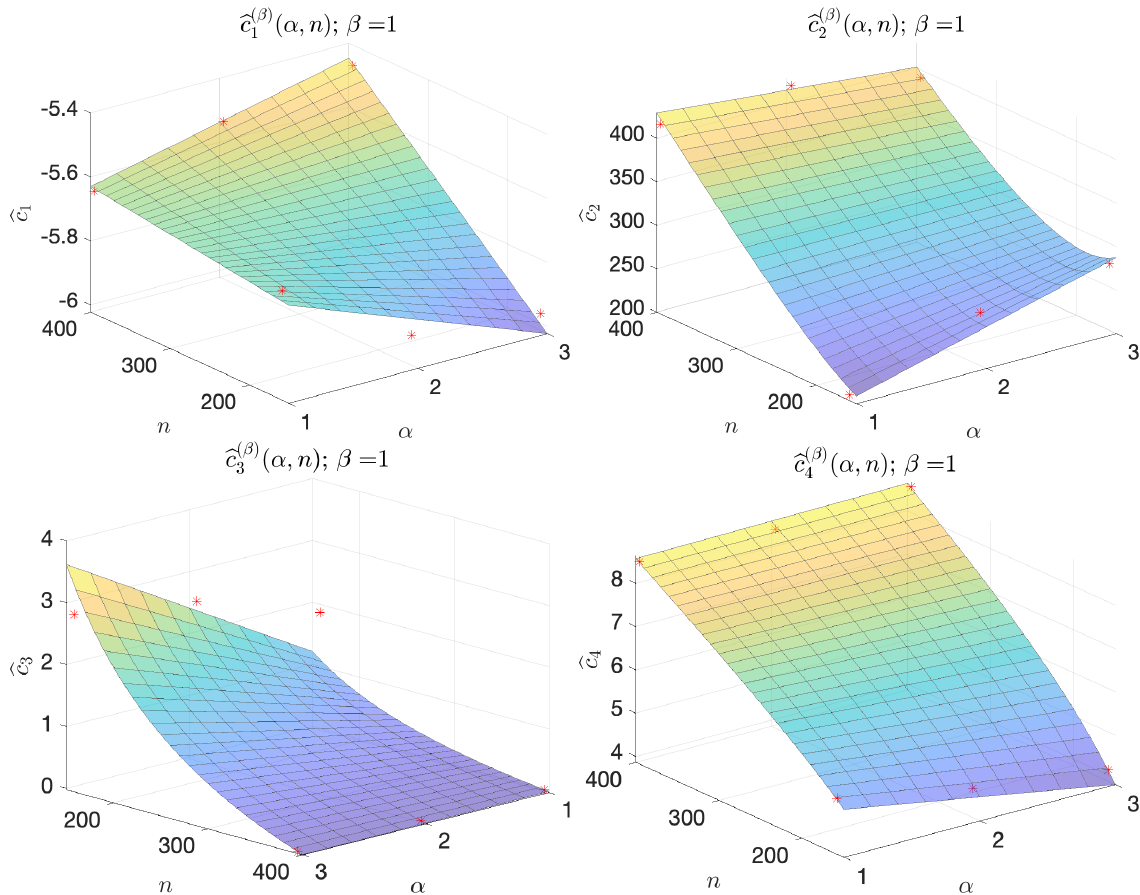
( β ) ( α , n ) fitting the coefficients (cid:98) c i